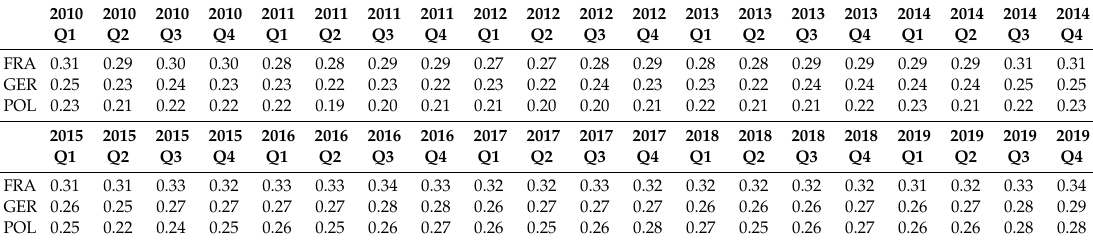
Table 2. Share of imports of consumption goods in total imports (in %), own work, source: Eurostat. 2010 Q1